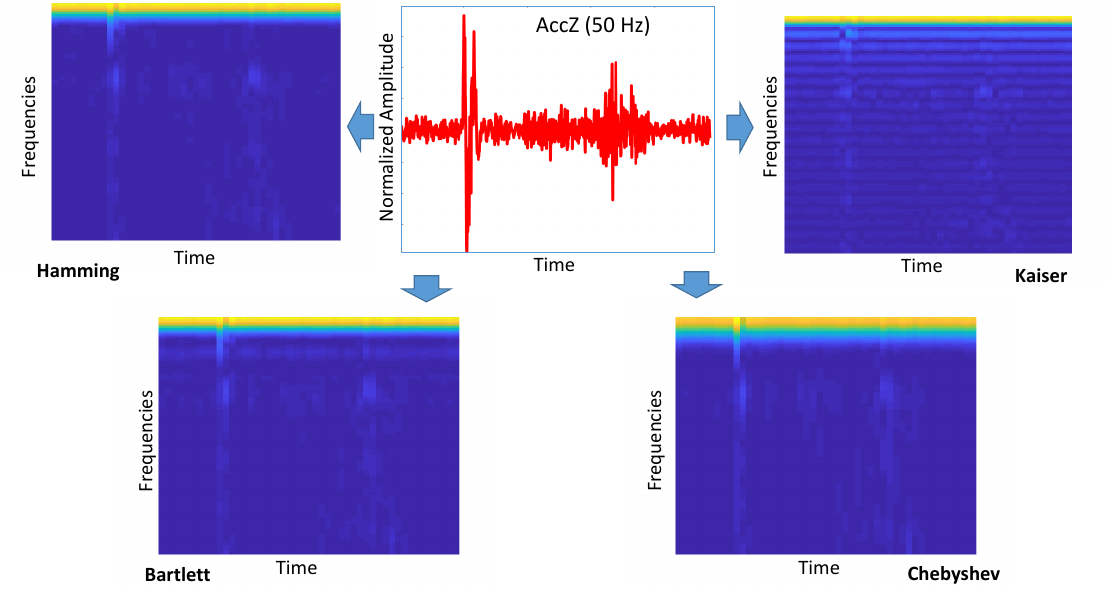
Figure 7. Application of the spectrogram to the Accelerometer Z (AccZ) output from the IMU.